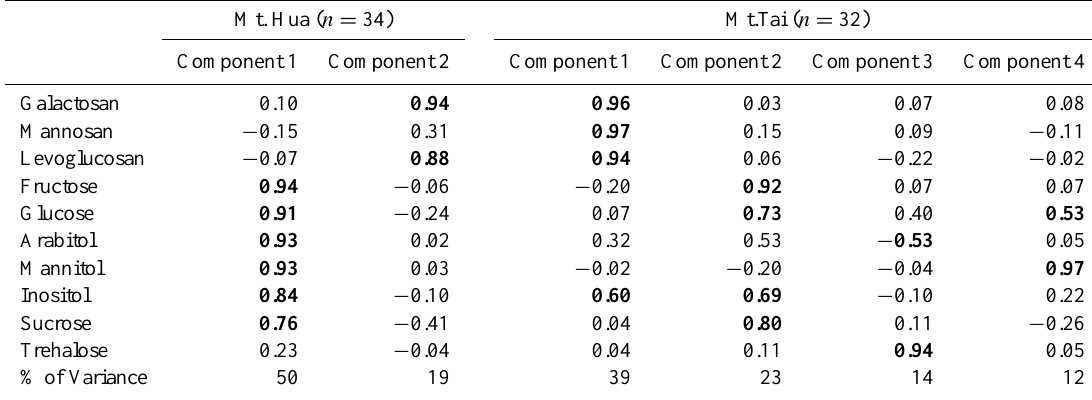
Table 3. Principal component analysis for sugars in PM 10 collected at Mt. Hua and Mt. Tai during spring